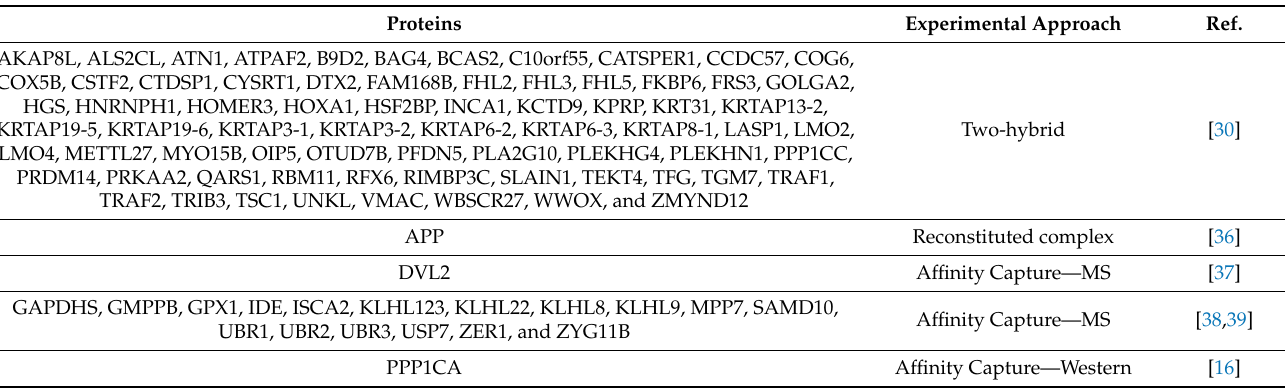
Table 1. IIIG9-interacting